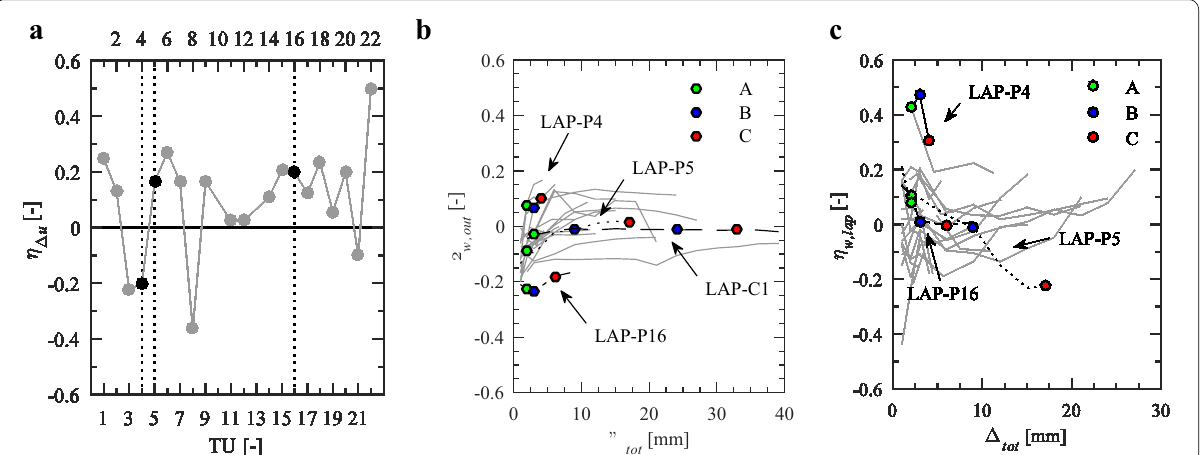
Fig. 11 Relative error for the simulation of all test units: a Ultimate element displacement. b Average crack width outside the lap-splice region. c Average crack width in the lap-splice